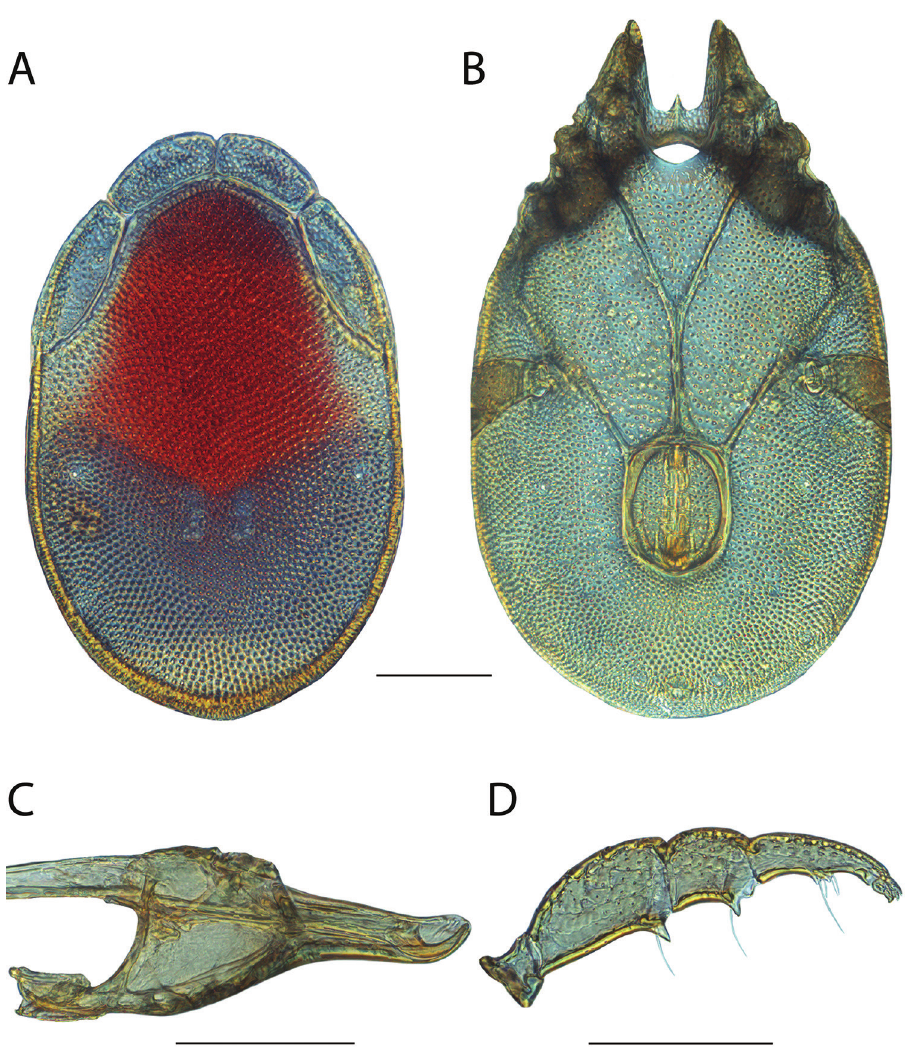
Figure 204. Torrenticola pulchra sp. n. male: A dorsal plates B venter (legs removed) C subcapitulum D pedipalp (setae not accurately depicted). Scale = 100 µm.